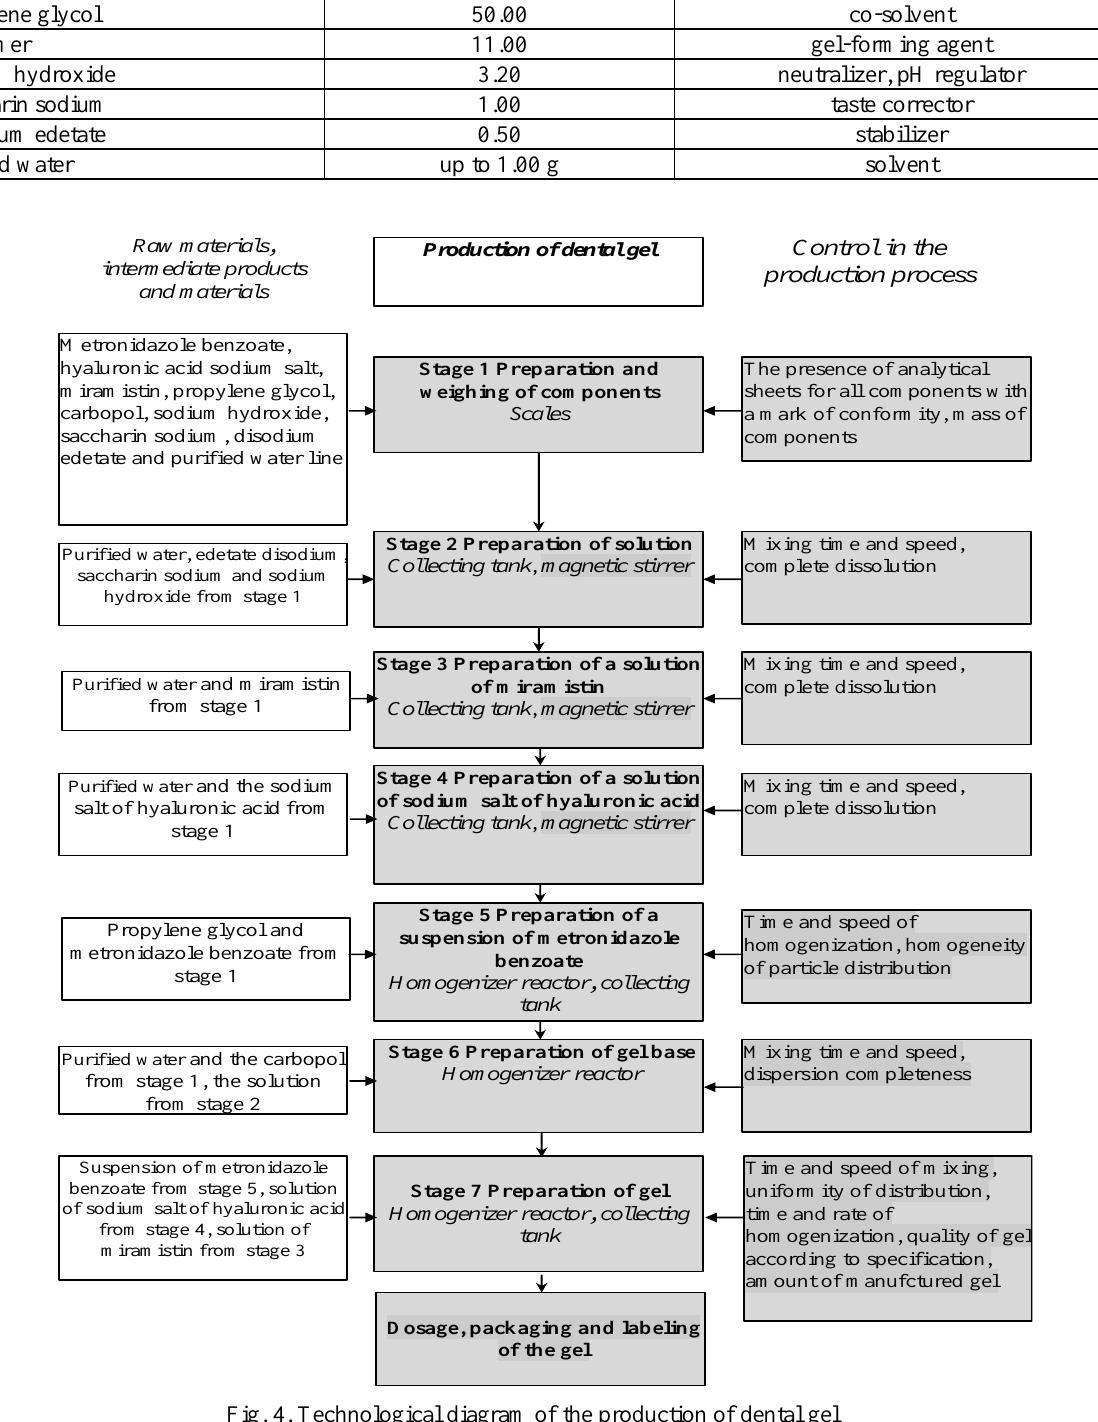
Fig. 4. Technological diagram of the production of dental